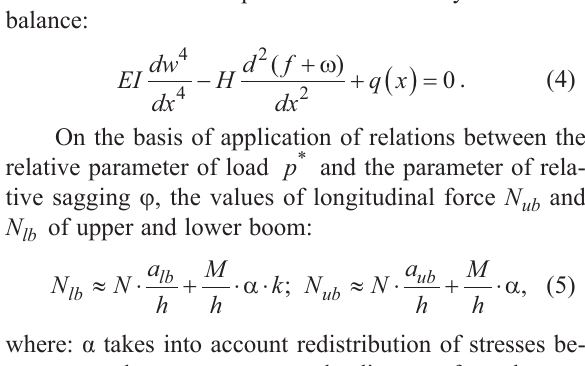
Algorithm of the engineering design of the